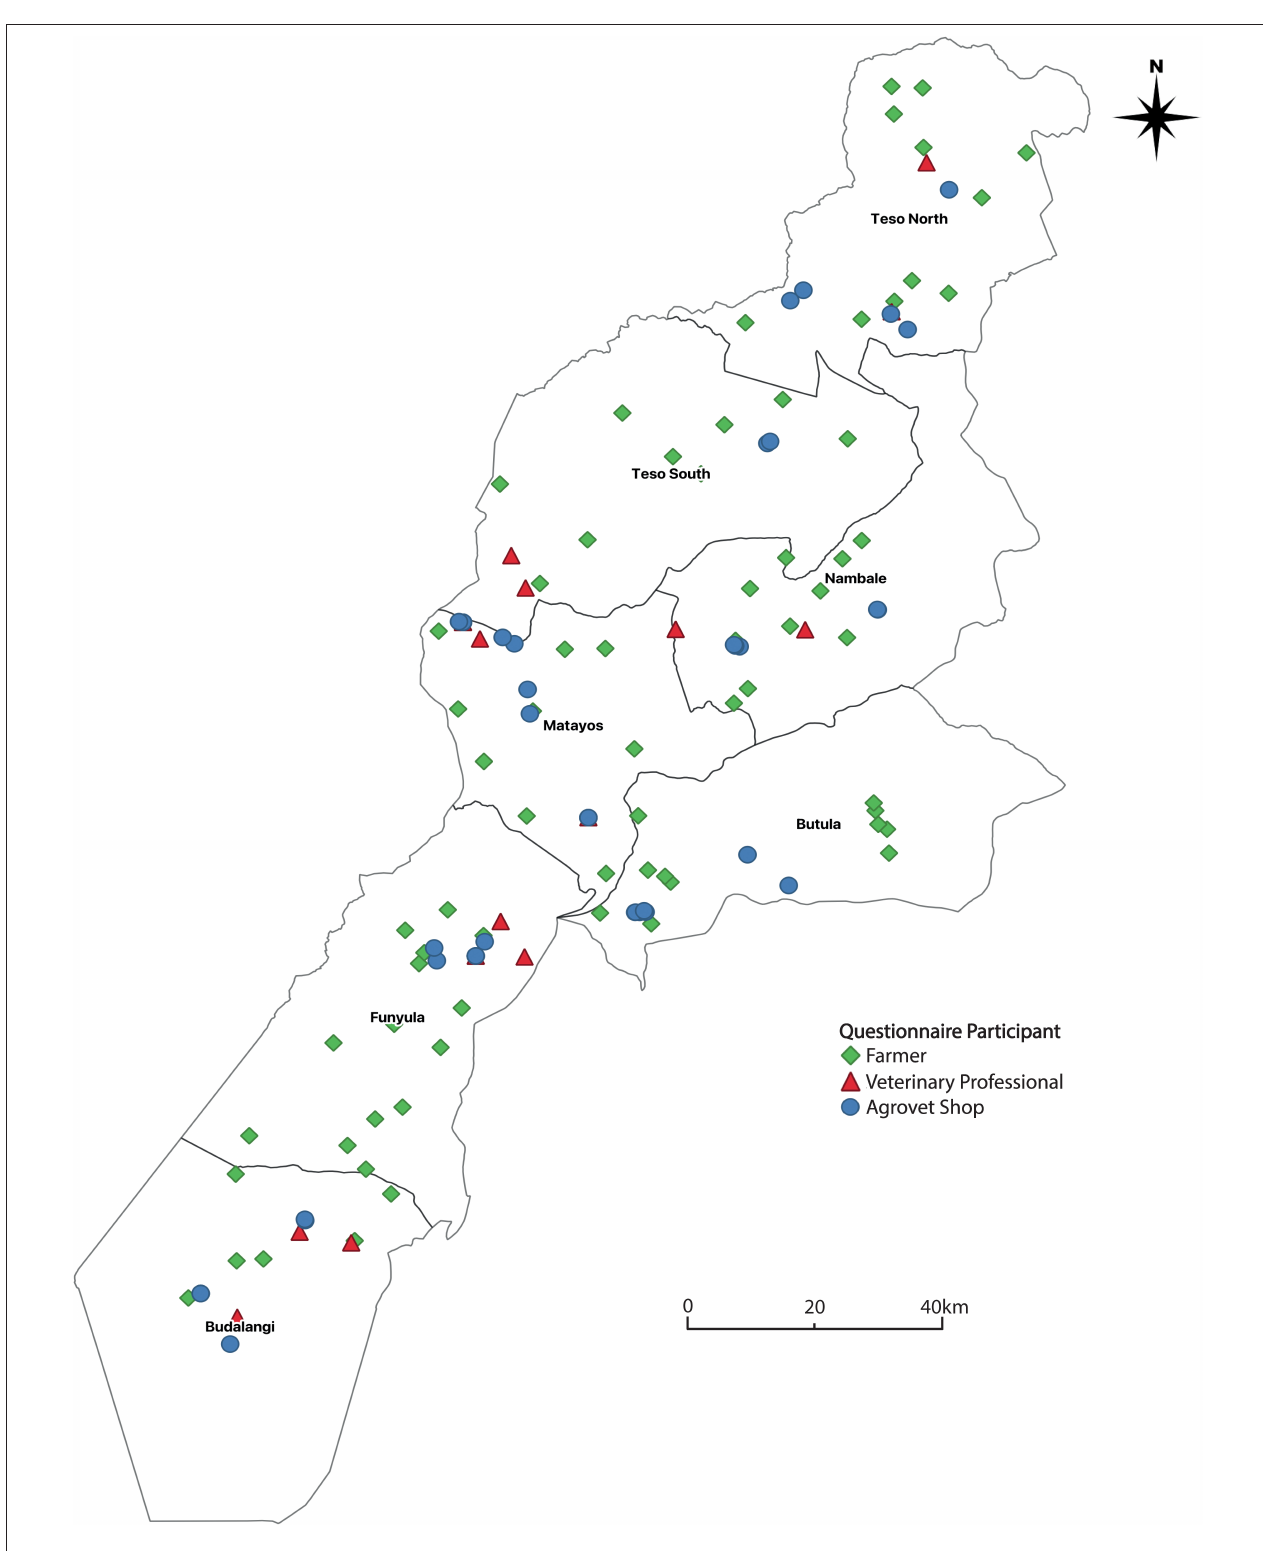
FIGURE 1 | Map of Busia county, western Kenya, indicating the locations of all interviewed farmers, agrovet staff (within their shops) and veterinary professionals.